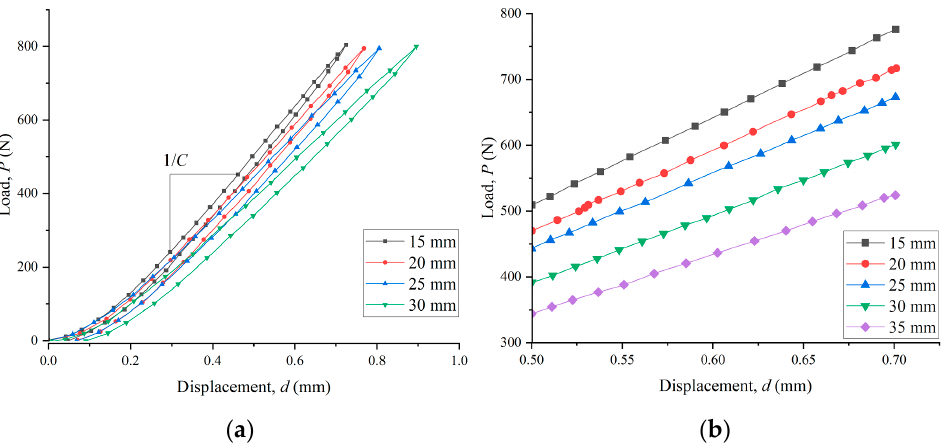
Figure 2. P - d curves from the compliance calibration of ENF specimens ( a ) original curve and ( b ) linear elastic section for the determination of compliance.